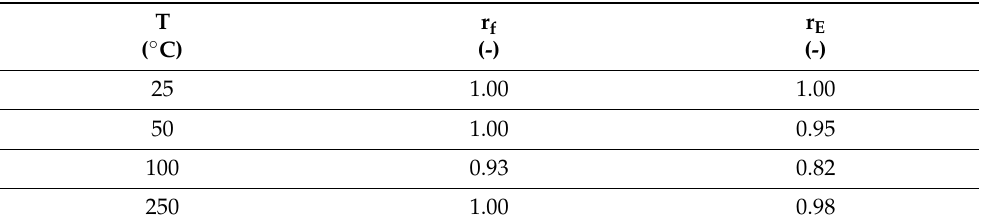
Figure 22. Temperature–tensile strength reduction factor curves [18,23,30].